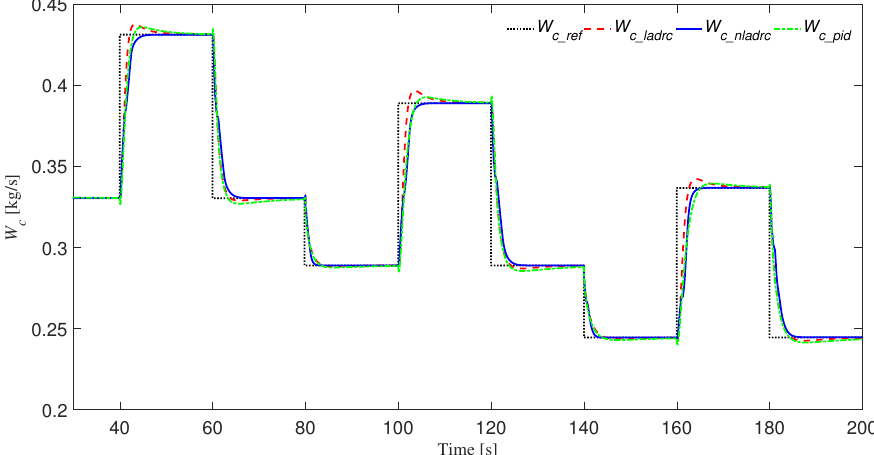
Figure 12. The response curve of mass air flow at different engine speeds.